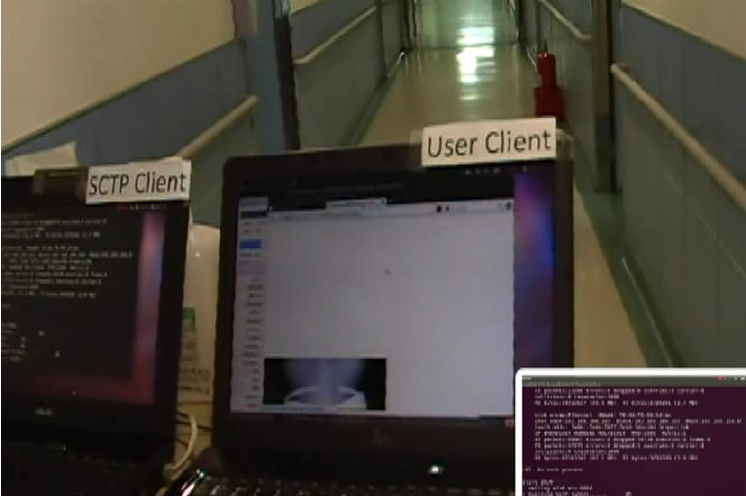
Figure 6. Seamless wireless switching between Wi-Fi and 3G in the